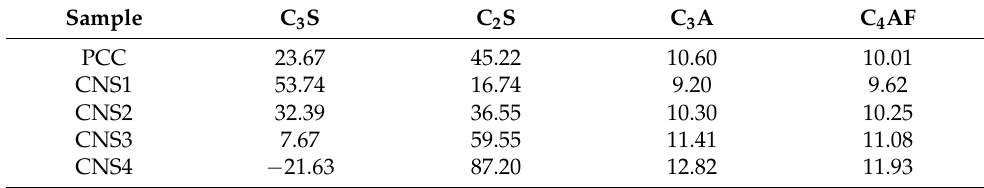
Table 3. The composition of C 3 S, C 2 S, C 3 A, and C 4 AF of cement with variation of Napa